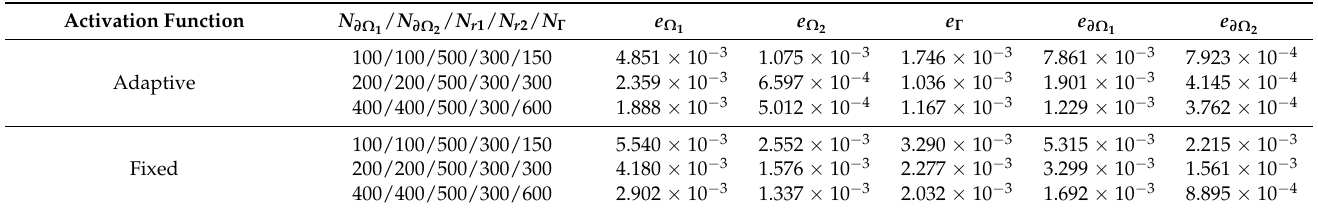
Table 11. Comparison of errors by adaptive and fixed activation function strategies with different numbers of training points for Example 6.